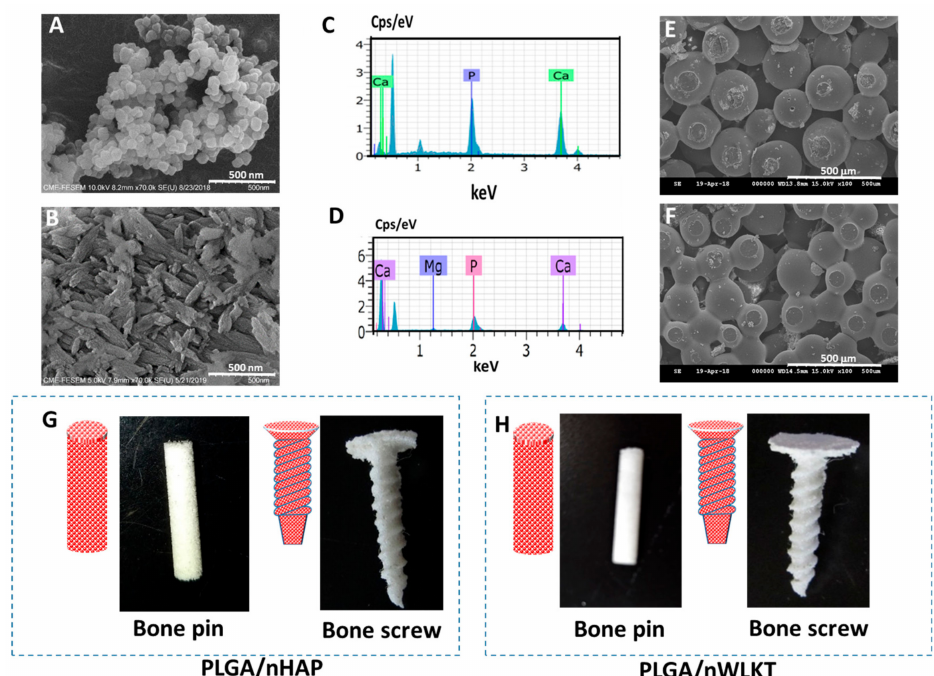
Figure 2. The characterization of nHAP and nWLKT by using scanning electron microscopy (SEM) ( A , B ) and electron dispersive X-ray spectroscopy (EDS) ( C , D ). The SEM images of PLGA / nHAP microsphere sca ff old ( E ) and PLGA / nWLKT microsphere sca ff old ( F ) confirm uniform surface sintering. Schematic drawings and photographs of PLGA / nHAP ( G ) and PLGA / nWLKT ( H ) bone grafts in a pin and screw shape after the surface sintering